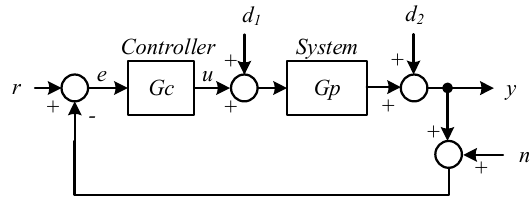
Figure 1. General closed-loop control system block diagram.